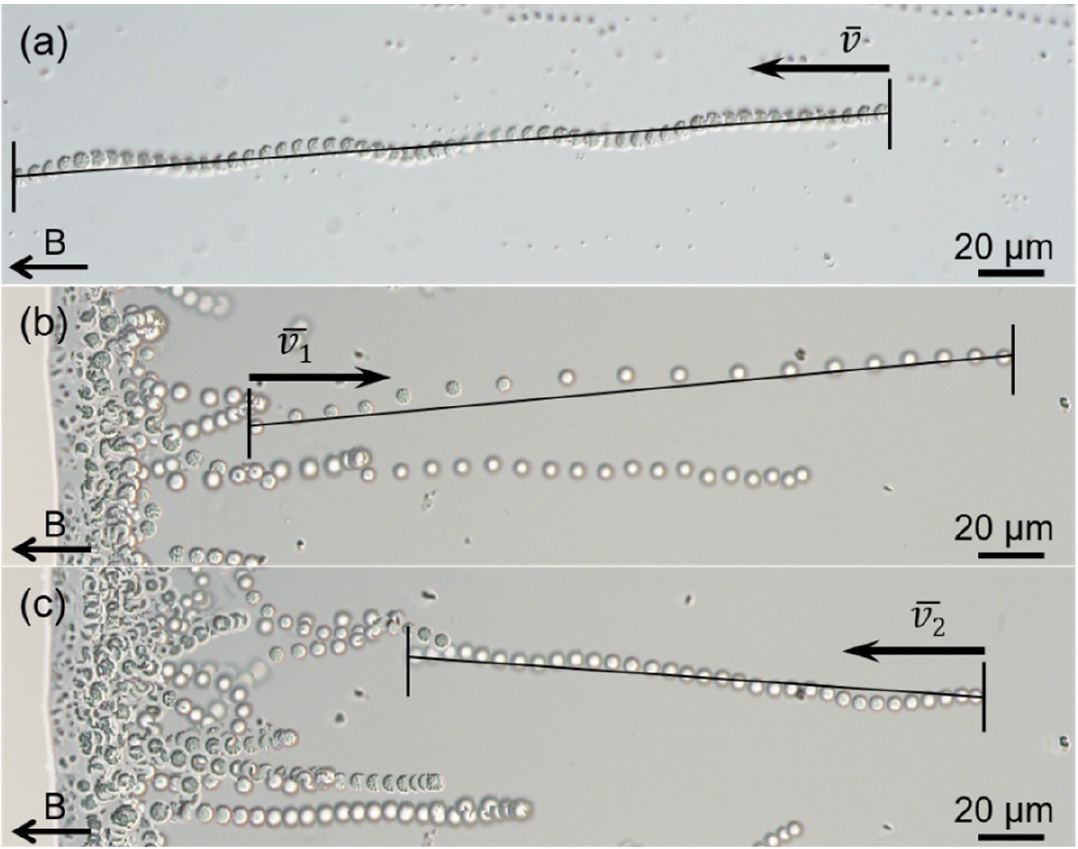
Figure 2. Motility of the sMMPs. Optical micrographs showing magnetotaxis motion ( a ), and excursion ( b ) and return ( c ) of the “ping-pong” motility. The black arrows at the bottom left of each image indicate the direction of the magnetic field. The swimming of the sMMPs was recorded at 20 frames per second (FPS).